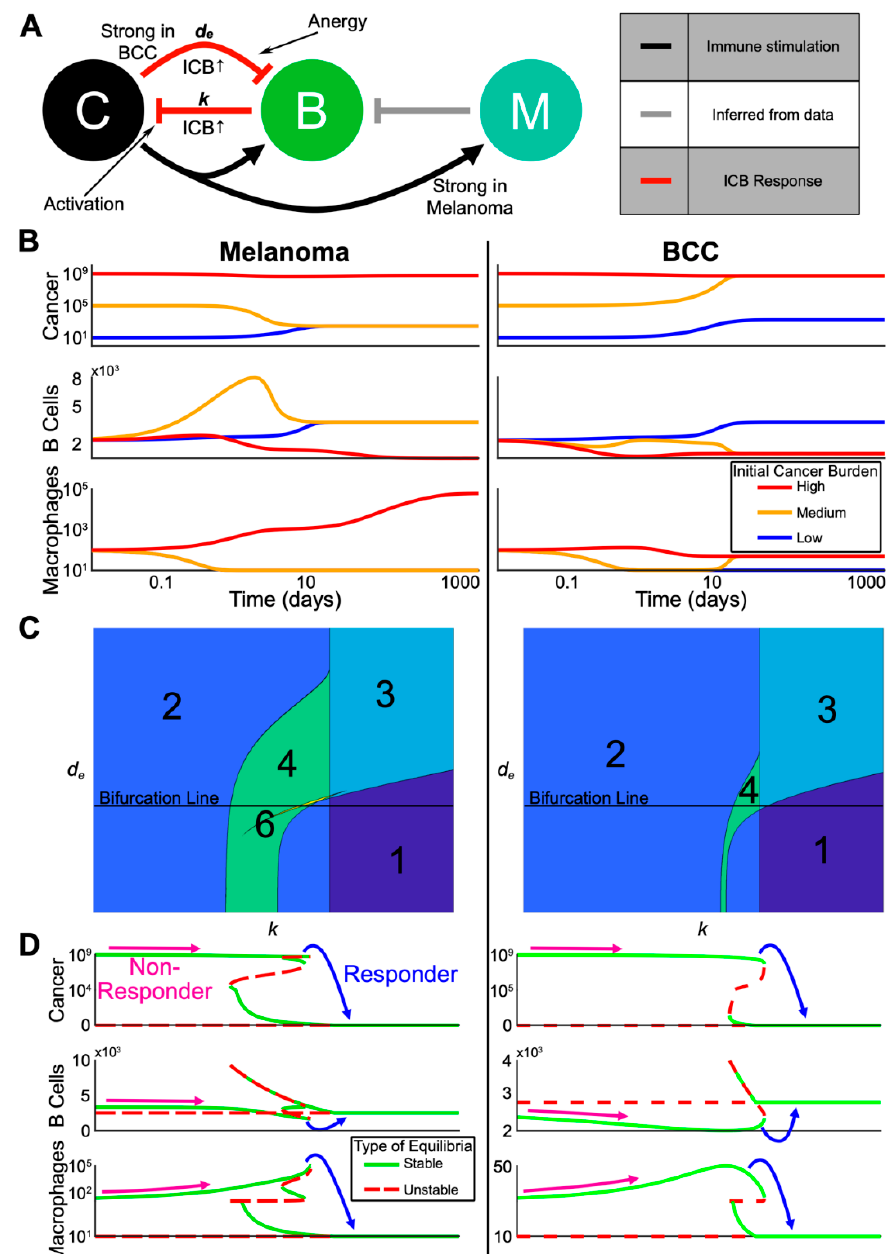
Figure 5. Multi-stability from complex interactions in melanoma and BCC can explain the heterogeneous response to ICB. ( A ) Schematic representation of the model (C = cancer, B = B cells, M = anti-inflammatory macrophages). Red arrows indicate processes assumed to be upregulated by checkpoint therapy. Grey arrow is inferred from our single-cell analysis. ( B ) Three trajectories with varying initial cancer population for each of melanoma and BCC. The color of the trajectory corresponds to the initial cancer population. All axes are log scale. ( C ) Contour plots showing the varying number of equilibria as the death rate of B cells (y-axis) and killing rate by B cells of cancer (x-axis) are varied. The “Bifurcation Line” indicates the values for which the bifurcations in ( D ) are plotted. ( D ) Bifurcation diagram in the killing rate, k , corresponding to the Bifurcation Line in ( C ). Possible starting and ending values for a non-responder and a responder are shown. Each Cancer and Macrophage axis is shown over two different scales for visualization purposes.